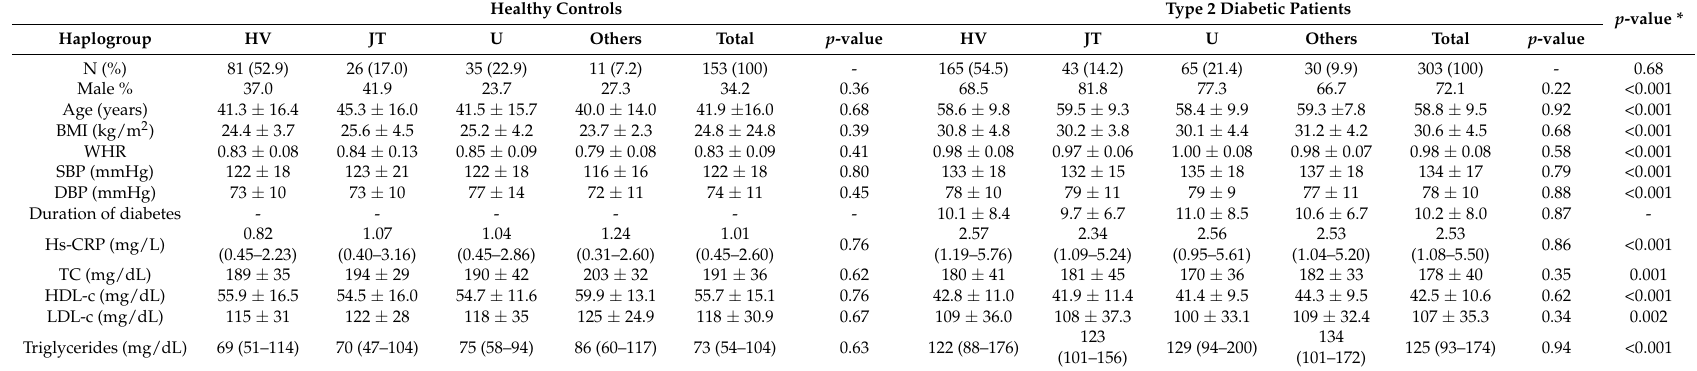
Table 1. Haplogroup distribution and characteristics of the study population. Anthropometrical, inflammatory and lipid